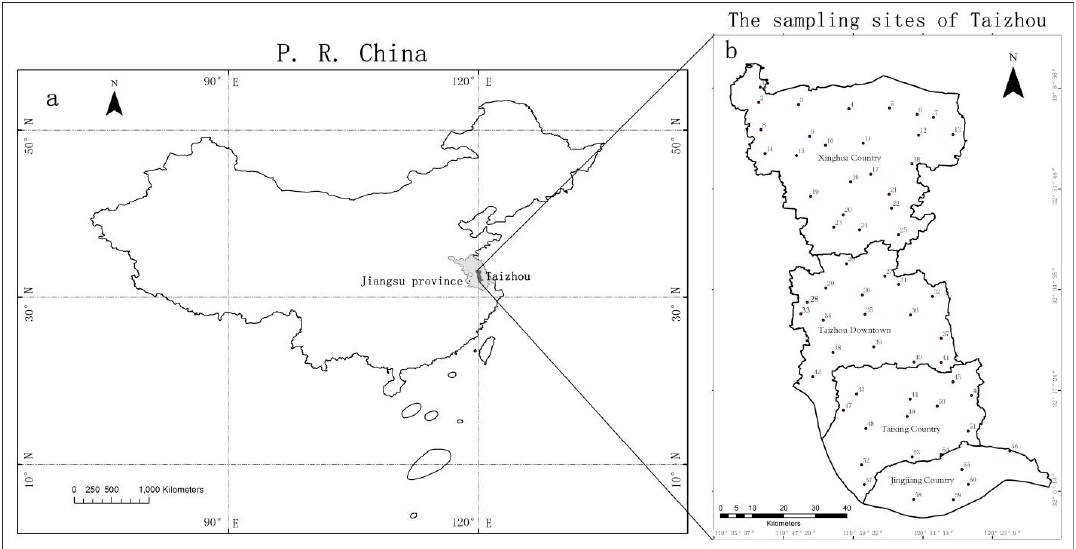
Figure 1. Location of Taizhou in China ( a ) and a map of Taizhou with the locations of the 60 moss-sampling sites (solid dots) ( b ). For the characteristics of each sample site, please refer to Table S1.